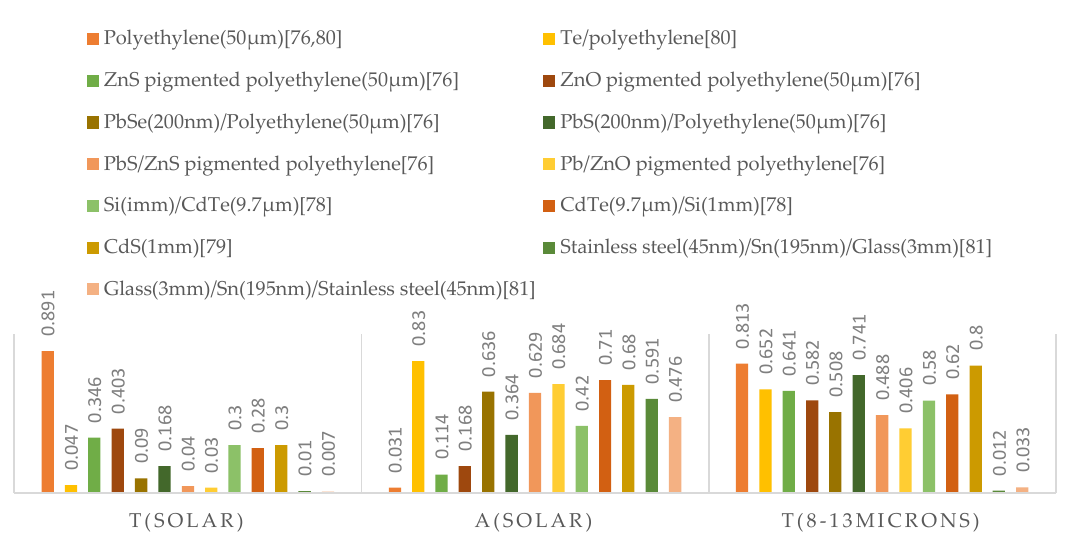
Figure 2. Radiative properties of different shields (T is transmittance and A is absorbance) (Origin: [77]).